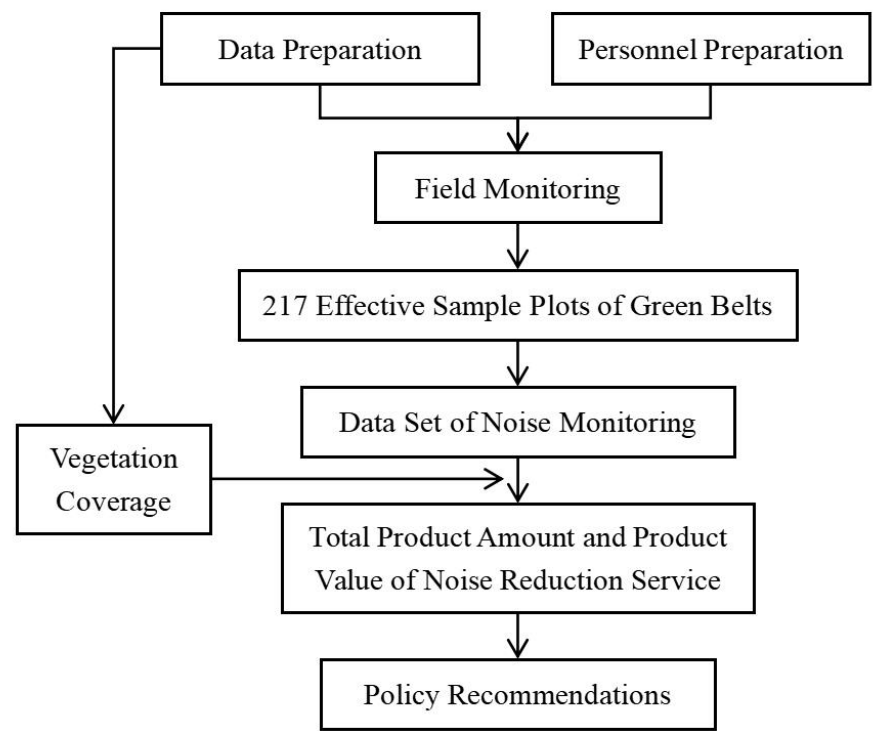
Figure 1. The workflow of this study.